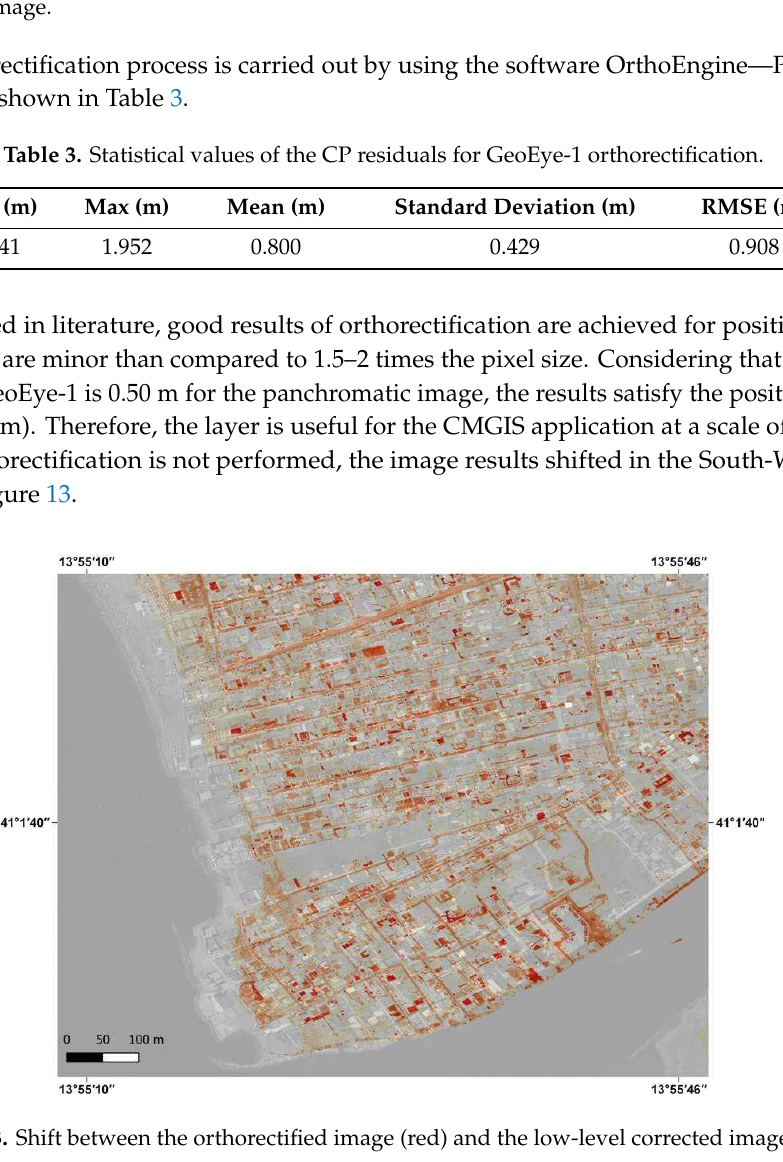
Figure 13. Shift between the orthorectified image (red) and the low-level corrected image (grey).